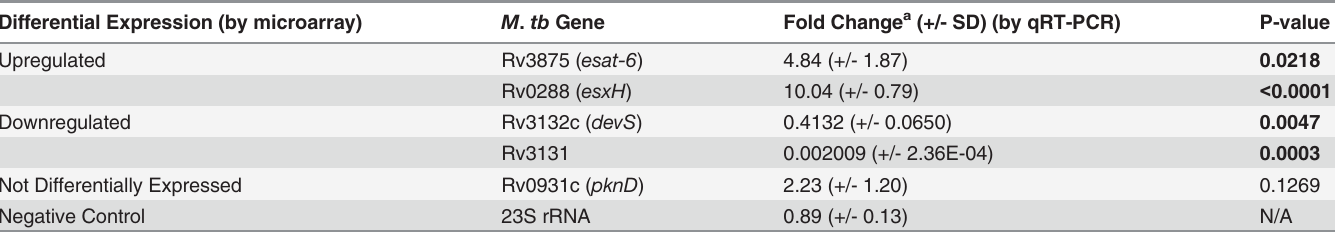
a Fold change indicates the ratio of the normalized number of transcripts for the select gene during M . tb infection of A549 cells to the normalized number of transcripts of the same gene during mid-log growth of M . tb in 7H9 media with standard deviation in parentheses. * P-value indicates the statistical comparison of fold change of the select gene to fold change of the negative control (23S RNA) by unpaired two-tail t test. P-values (cid:1) 0.5 are statistically signi fi cant and are highlighted in